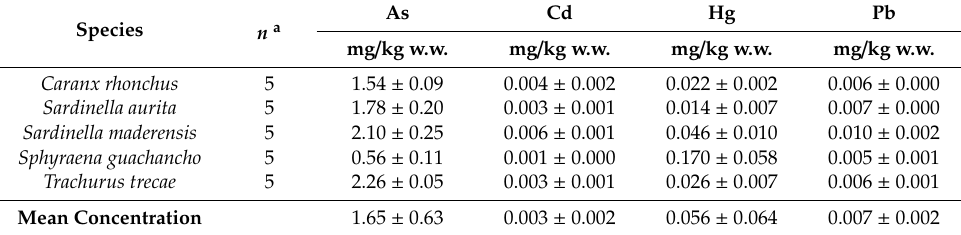
Table 5. Concentrations of arsenic (As), cadmium (Cd), mercury (Hg), and lead (Pb) in fish from Angola (mean ±